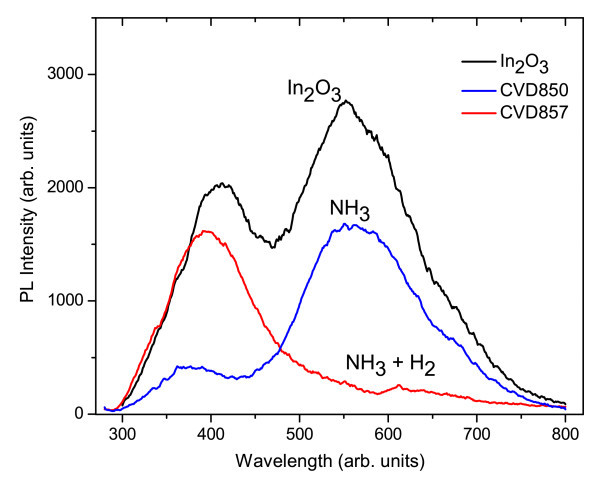
PL spectrum of In2O3 NWs as grown and after nitridation using NH3 only or NH3 and H2.